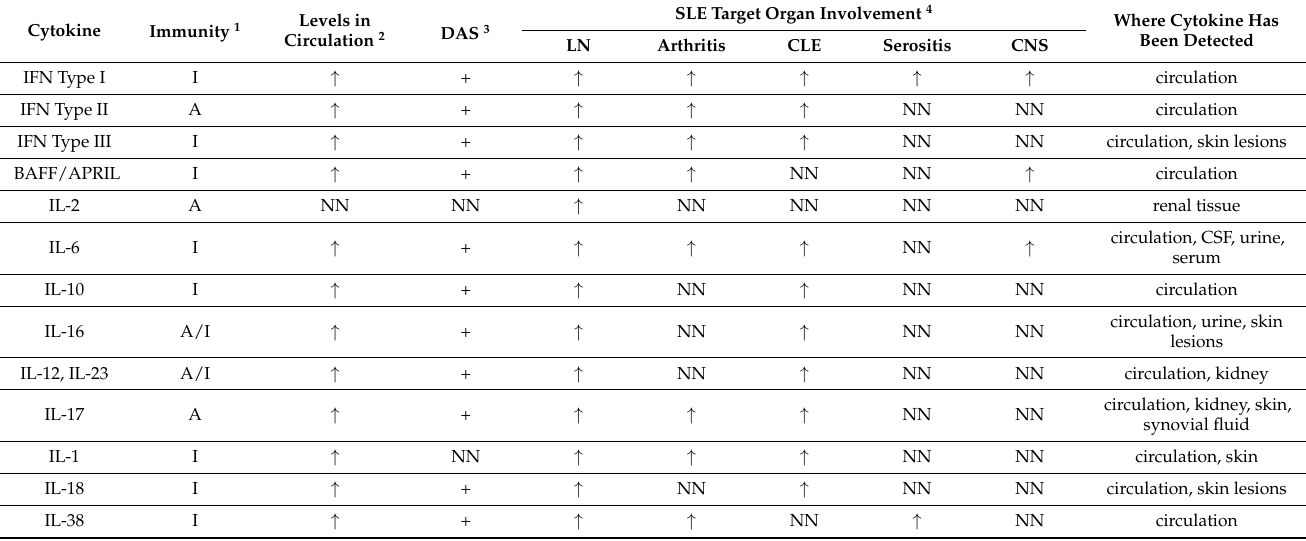
Table 1. Overview of the cytokine regulation in the circulation, their correlation to disease activity, as well as association with and expression in the target organs of active